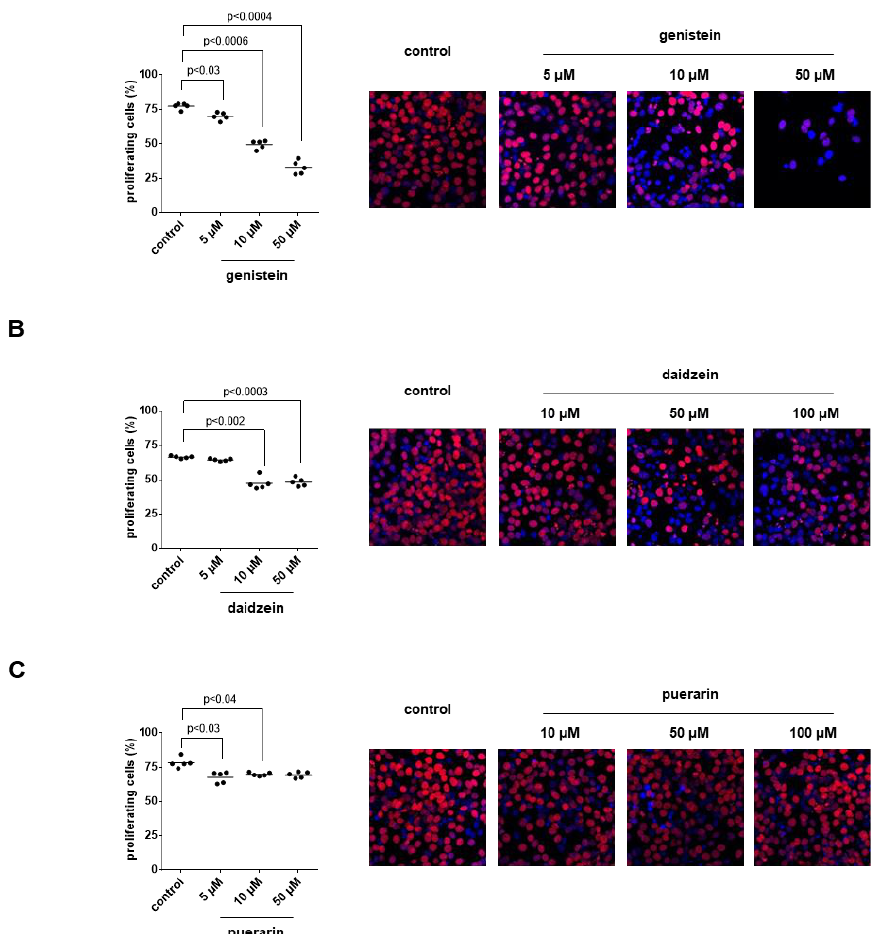
Figure 8. Effects of genistein, daidzein and puerarin on the proliferation of WPMY-1 cells. Proliferation was assessed by EdU assays (red, proliferating cells; blue, non-proliferating cells) after the cells were cultured for 24 h with genistein ( A ), daidzein ( B ) and puerarin ( C ) at the indicated concentrations or with solvent (DMSO for genistein and daidzein, methanol for puerarin) for the controls. Shown are all single values together with means from the quantification of proliferating cells in five independent experiments, along with representative images for each series, and p -values from comparisons with values for the corresponding DMSO group determined by one-way ANOVA with Dunnett’s tests.